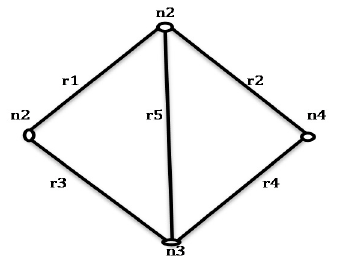
Figure 9. Bridge Figure 9. Bridge Network Table 3. Comparison of different methods.